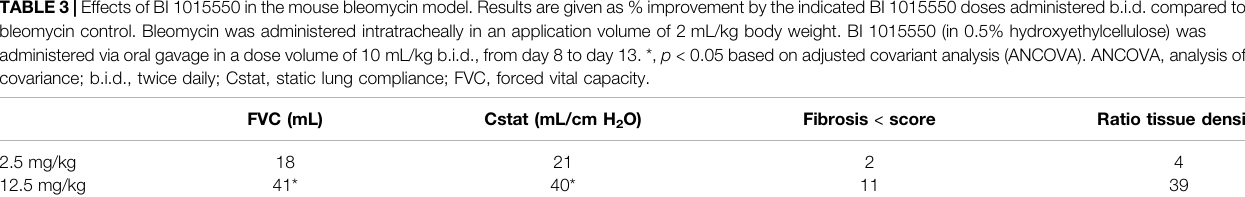
events per animal (data not shown). With 6 mg/kg BI 1015550